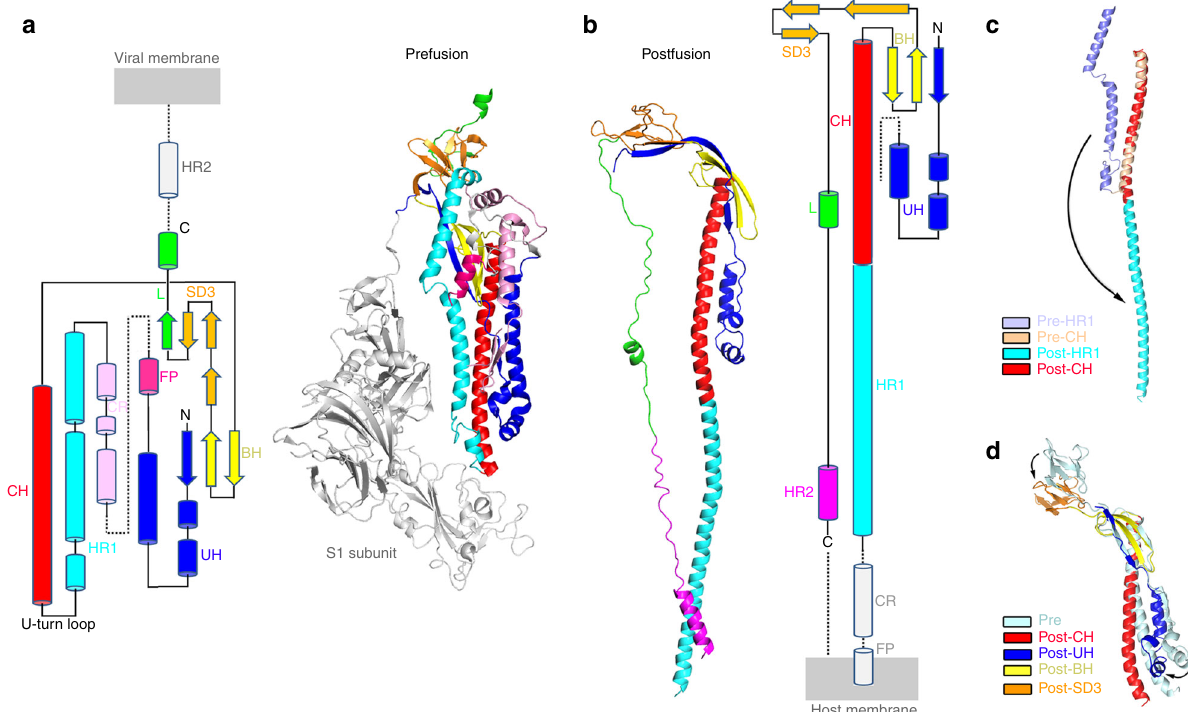
Fig. 2 Structural and conformational changes of SARS-CoV S glycoprotein from pre-fusion to post-fusion state. a Topology and cartoon representation of SARS-CoV S2 subunit in pre-fusion state 20 (PDB: 6NB6) colored as in Fig. 1a. The S1 subunit in the pre-fusion state is colored white. b Topology and cartoon representation of SARS-CoV S2 subunit in post-fusion state colored as in Fig. 1a. Unobserved regions in the structures are colored in light gray or presented as dashed lines in the topology diagram of ( a , b ). c Structural transition of the HR1 and CH motifs during membrane fusion. d Structural changes of the UH, BH, and SD3 during membrane